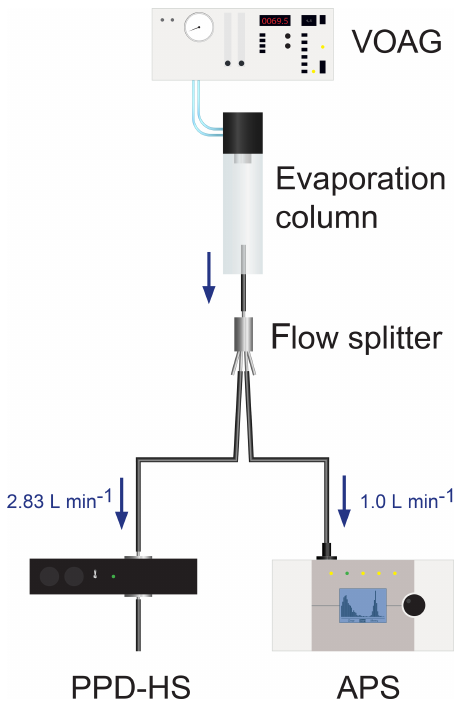
Figure 3. Experimental setup used for PPD-HS calibration mea- surements. A VOAG was used to generate both spherical and as- pherical particles of different sizes. An APS was operated in par- allel to PPD-HS, in order to monitor the particle size distribution (see example size distribution in Supplement Fig. S12). A vacuum pump, attached downstream of PPD-HS, is used to draw air through